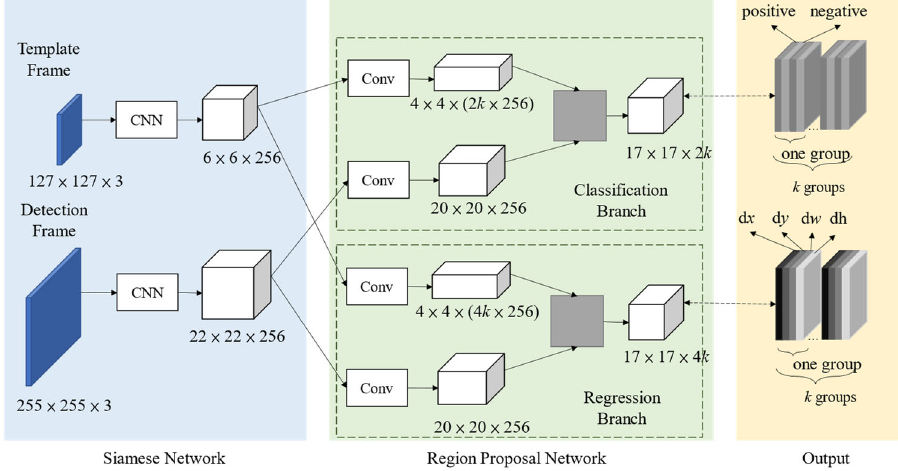
Figure 7. The main neural network framework of SiamRPN: the blue part is the Siamese subnet used for feature extraction, the green part is the regional proposal subnet, and the orange part is the final output result. There are two branches in the figure, one for classification and the other for regression.